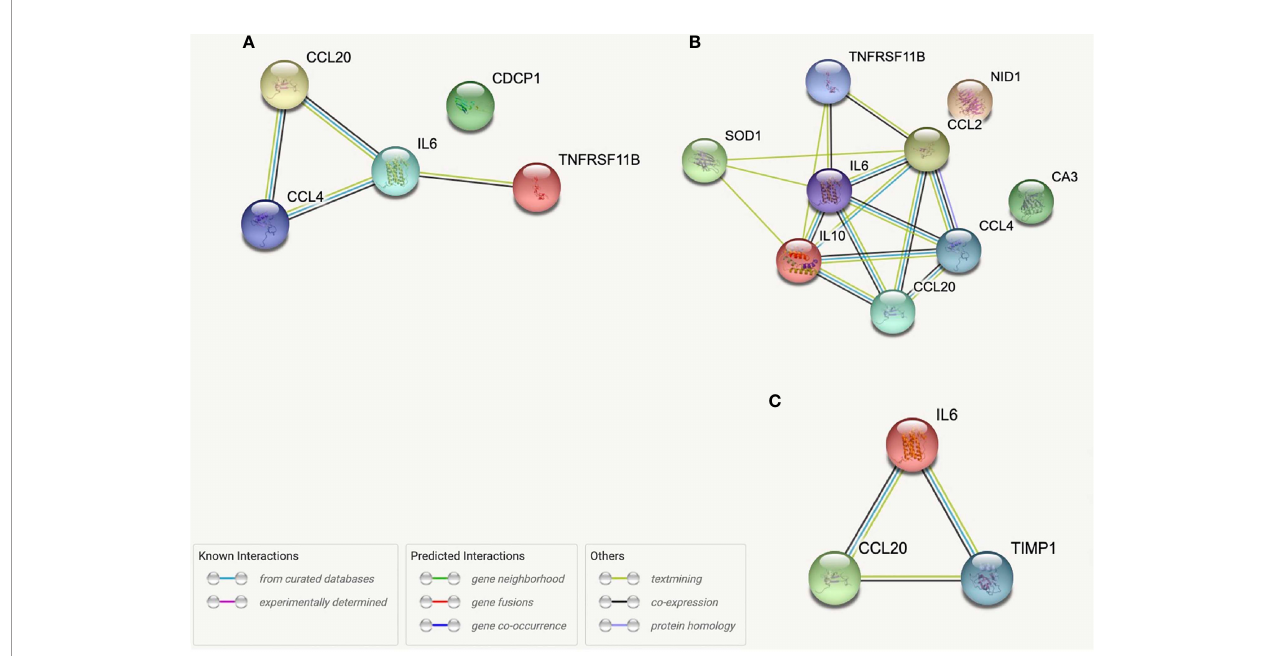
FIGURE 6 | STRING protein networks for systemic proteins correlated with both Isobutyrate and NIHSS admission scores (A) , systemic proteins correlated with both 2-Methybutyrate and NIHSS admission scores (B) and intracranial proteins correlated with Isobutyrate, 2-Metlybutyrate and NIHSS Admission Scores (C) . *OPG, TNFRSF11B; MCP-1, CCL2; LAP-TGFB1 was not found in STRING.